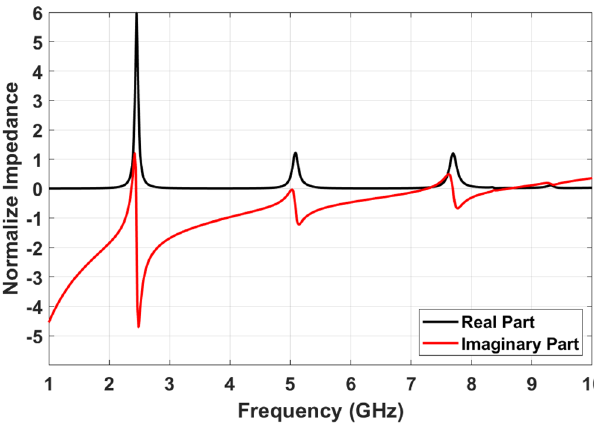
Figure 7. Input impedance of SIW cavity resonator.